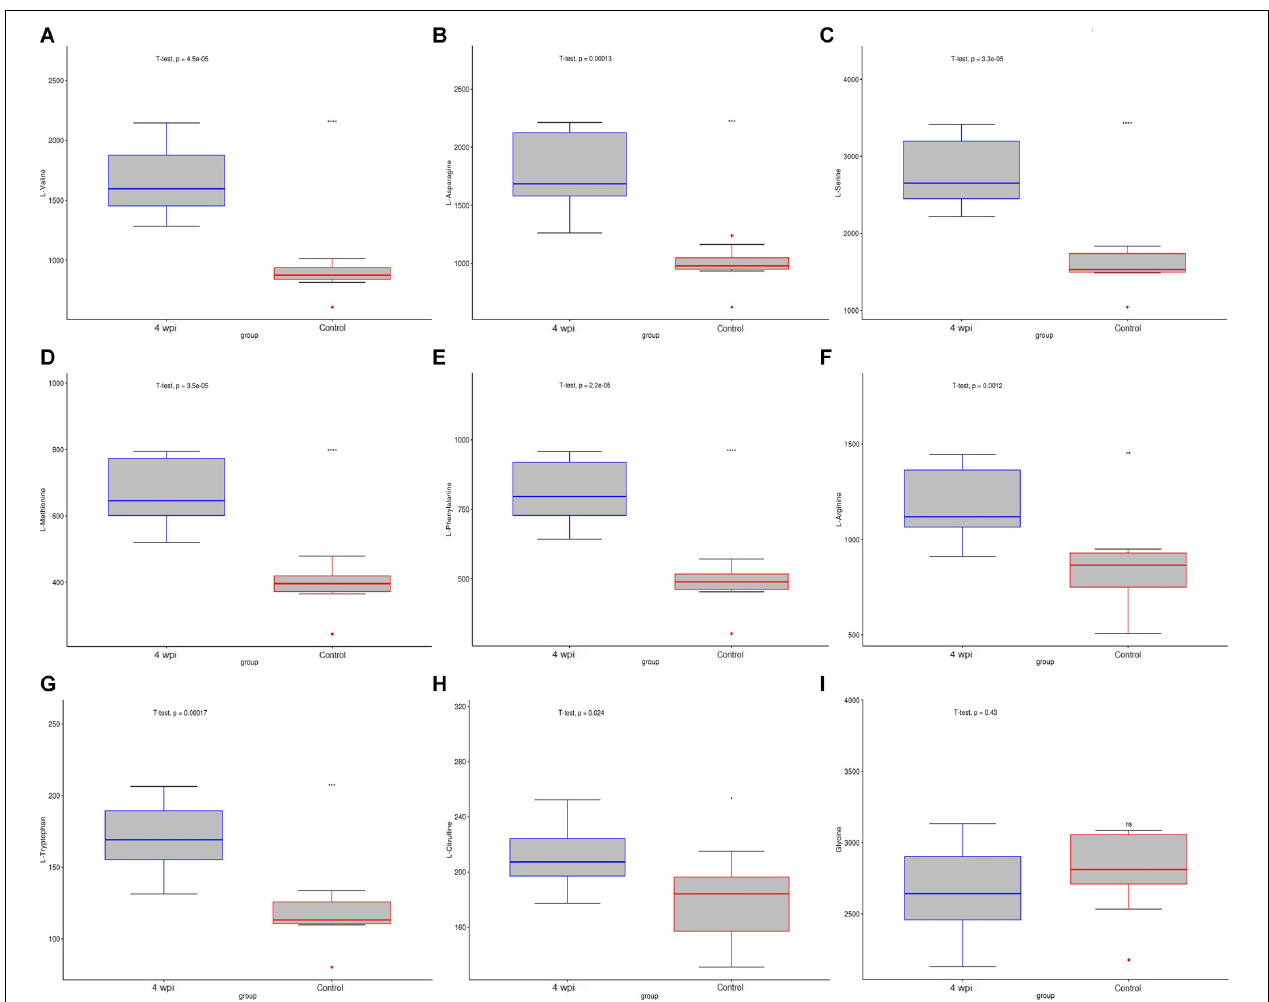
FIGURE 6 | The distribution of amino acids were present by boxplot between 4 wpi vs control group. (A) L -Valine; (B) L -Asparagine; (C) L -Serine; (D) L -Methionine; (E) L -Phenylalanine; (F) L -Arginine; (G) L -Tryptophan; (H) L -Citrulline; (I) Glycine. Boxes represent the interquartile ranges (IQRs) between the first and third quartiles, and the line inside the box represents the median. The amino acid content was compared with the median value between the two groups. Circles represent outliers. * P < 0.05, *** P < 0.001.